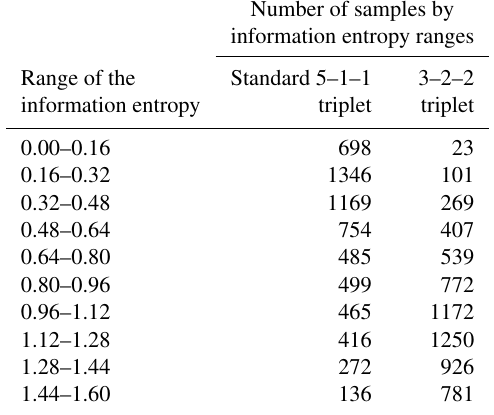
Table 1. Total numbers of samples by ranges of the information entropy for two textural fraction triplets. The 3–2–2 triplet includes very coarse, coarse, and medium sand (fraction 1), fine and very fine sand (fraction 2), and clay and silt (fraction 3); the standard triplet 5–1–1 includes sand (fraction 1), silt (fraction 2), and clay (fraction 3). Number of samples by information entropy ranges Range of the Standard 5–1–1 3–2–2 information entropy triplet